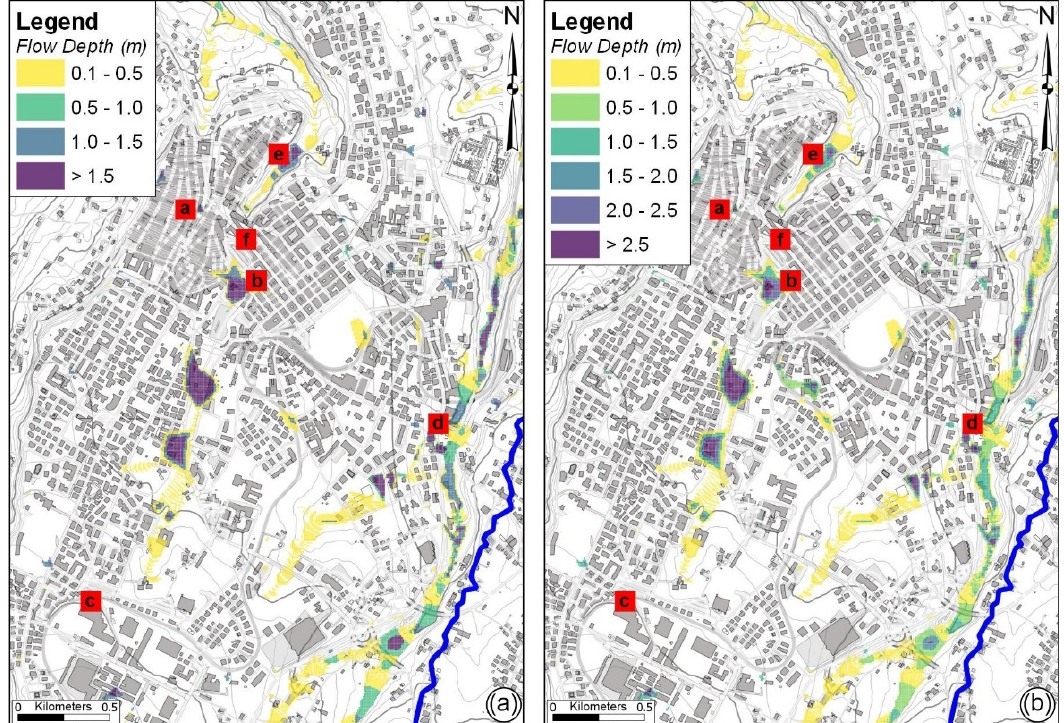
Figure 15. Results of the FLO-2D simulation, in the Lanciano urban area: ( a ) using the first rainfall diagram (moderate intensity, 24 h duration, Figure 13a) and ( b ) using the second rainfall diagram (high intensity, 4 h duration, Figure 13b). The red boxes represent the urban critical areas listed in Table 5. Critical areas a and c represent the areas in Figure 9a and Figure 9b, respectively. Blue line: Feltrino Stream basin.